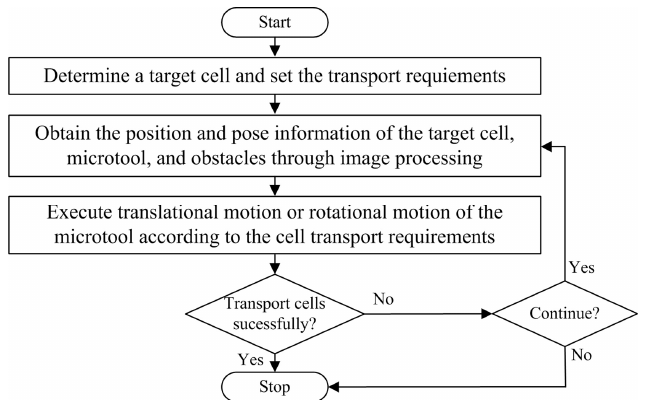
Figure 4. Control sequences of indirect transport of biological cells with the robot-aided HOT system by manipulating the microtool.